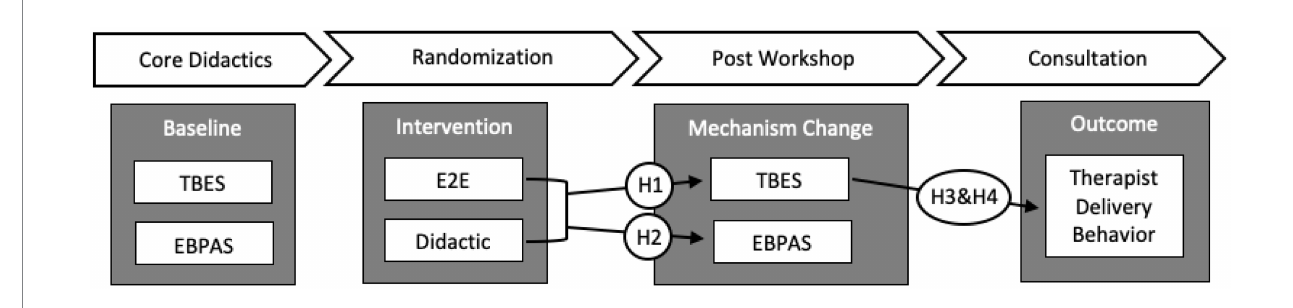
FIGURE 3 Training activities, hypotheses, and measurement strategy. EBPAS = Evidence Based Practice Attitudes Scale; TBES = Therapist negative Beliefs about Exposure.